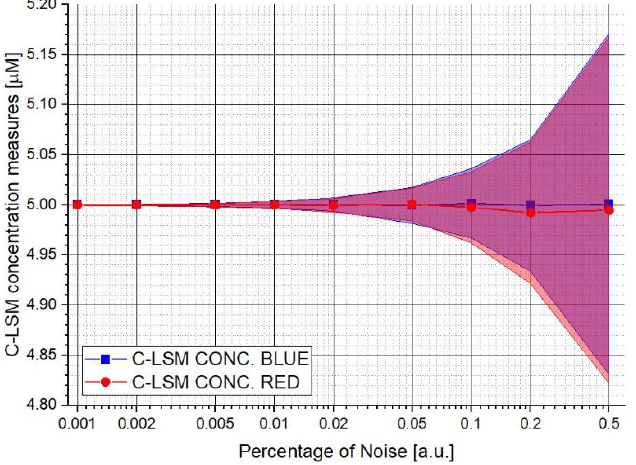
Figure 1. Concentration measurements made by the C-LSM algorithm varying the percentage of noise value. In the plot are reported the increment in the uncertainty in concentration measurements as a function of the increase in noise level.